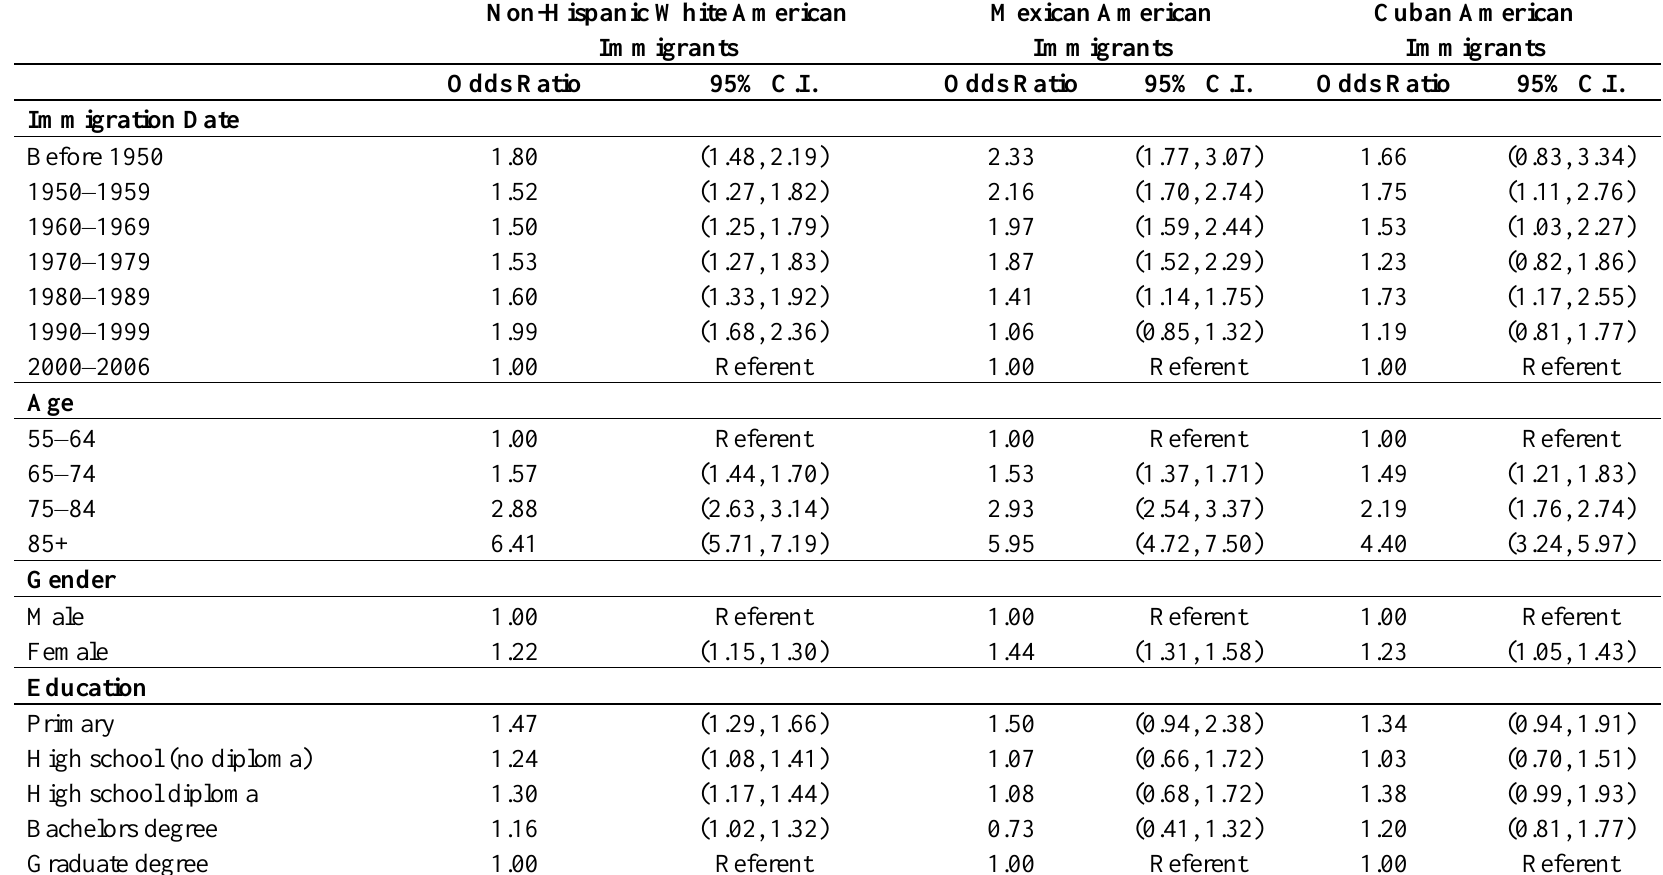
Table 4. Logistic regression analyses of functional limitations status by decade since immigration for non-Hispanic White American Immigrants, Mexican American Immigrants and Cuban American Immigrants controlling for socio-demographic characteristics, English skills & citizenship